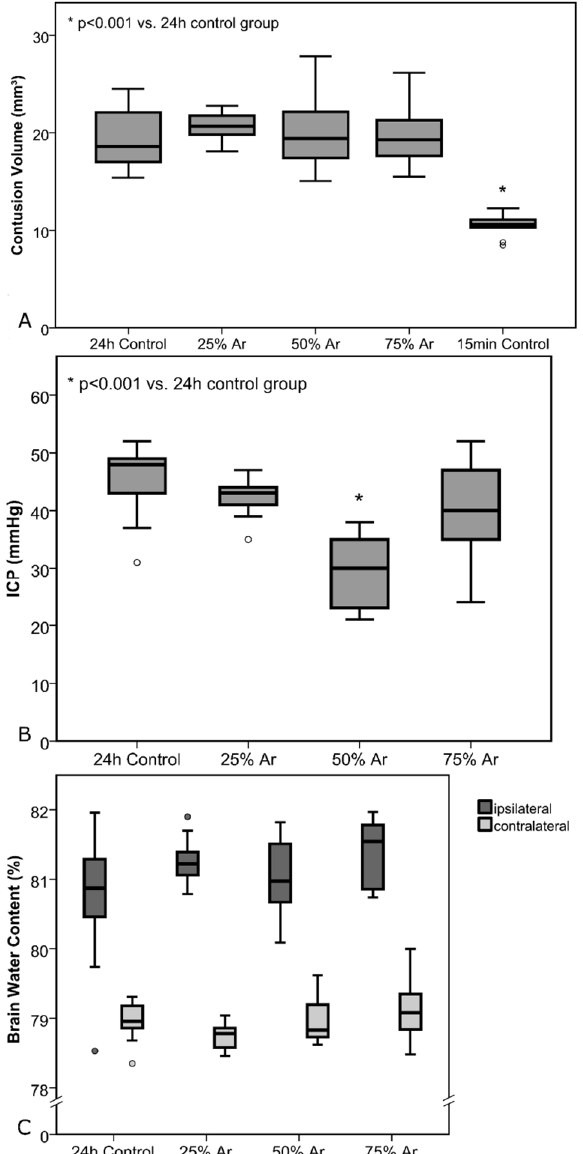
Figure 5. Test series A: Treatment was administered 30 min before trauma until 4 h after trauma. All results are shown as standard boxplot charts. ( A ) Contusion volumes for the control groups and the animals treated with argon. Brains for the 15 min control group were removed after 15 min to determine primary damage. All other brains were removed 24 h after CCI. There was a highly significant increase due to secondary damage when comparing 15 min and 24 h control groups ( p < 0.001). The number of animals per group were as follows: 24 h control = 10; 25% Ar = 8; 50% Ar = 10; 75% Ar = 9; 15 min control = 10. ( B ) Intracranial pressure (ICP) values 24 h after TBI. There was a highly significant difference between the 24 h control and 50% Ar group ( p < 0.001). ( C ) Brain water content (BWC) values of each hemisphere 24 h after TBI, divided by groups (the number of animals per group in Graph B and C were as follows: 24 h control = 9; 25% Ar = 9; 50% Ar = 10, 75% Ar =